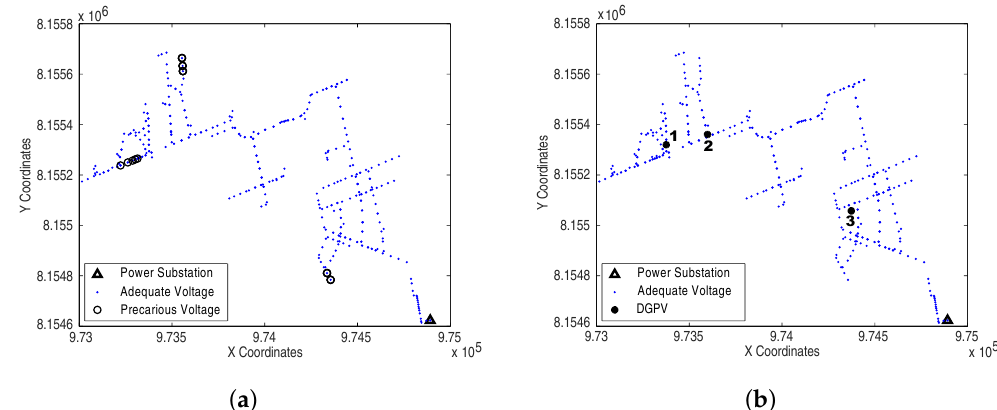
Figure 15. Scenario 3: ( a ) voltage rating before DGPV allocation and ( b ) voltage rating after DGPV allocation.